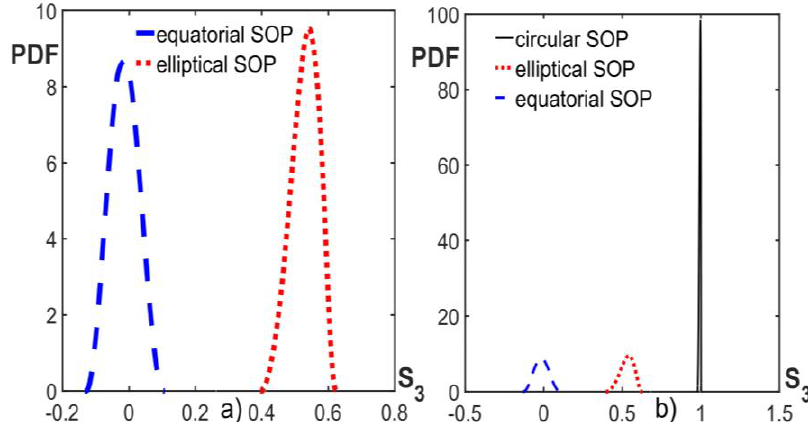
Figure 8. Mean S 3 pdf: ( a ) comparison between equatorial and elliptical SOPs, ( b ) comparison between equatorial, elliptical and circular SOPs.